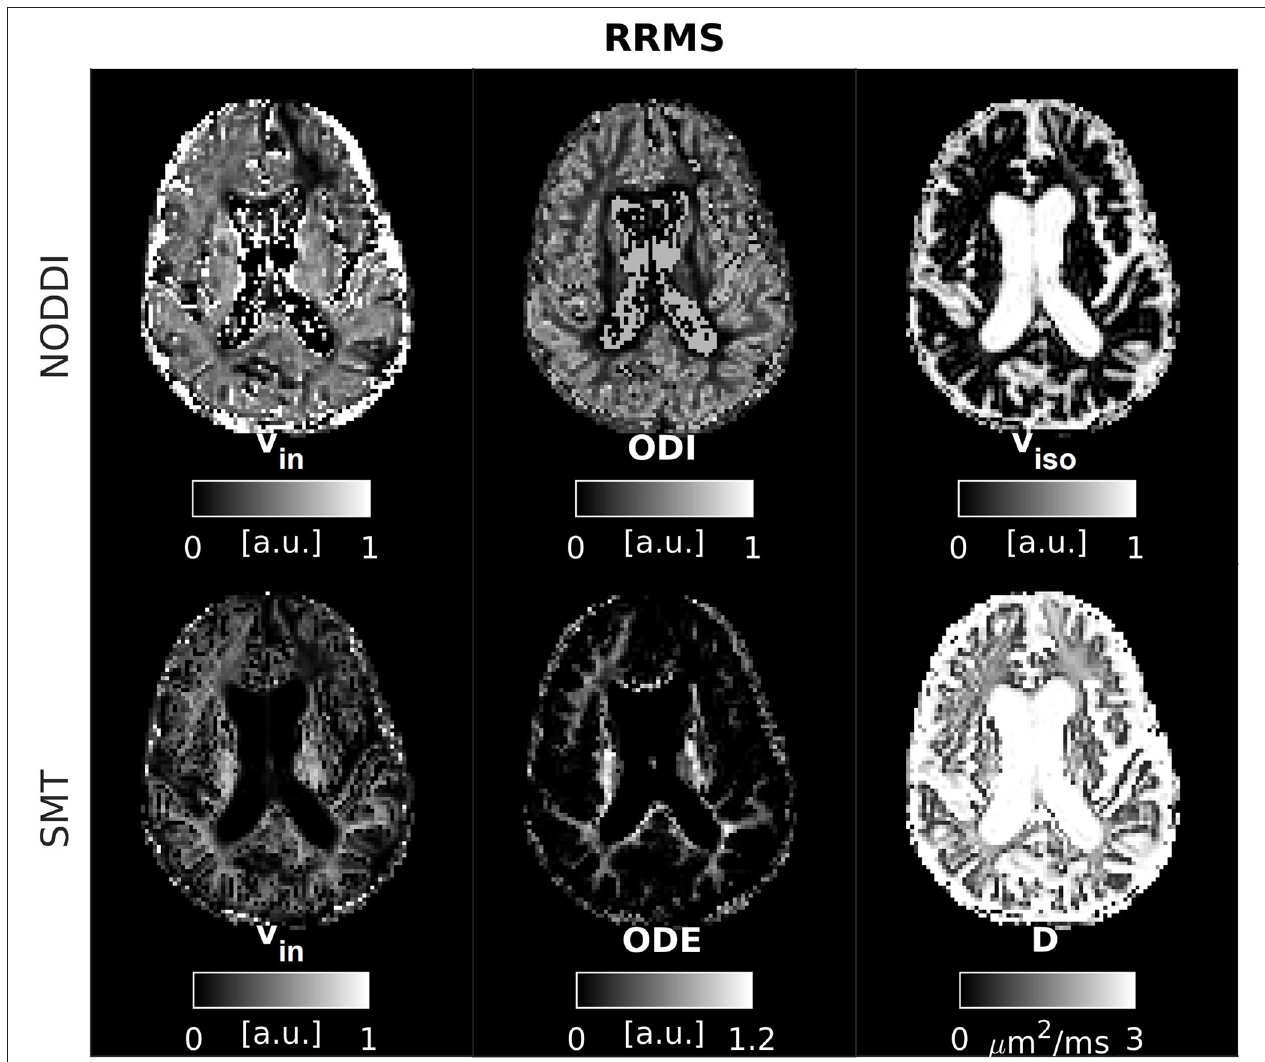
FIGURE 3 | NODDI and SMT metrics as obtained from an MS patient. Top : NODDI ( left : intra-neurite volume fraction v in ; orientation dispersion index ODI; isotropic volume fraction v iso ); bottom : SMT (intra-neurite volume fraction v in ; orientation dispersion entropy ODE; neural diffusivity